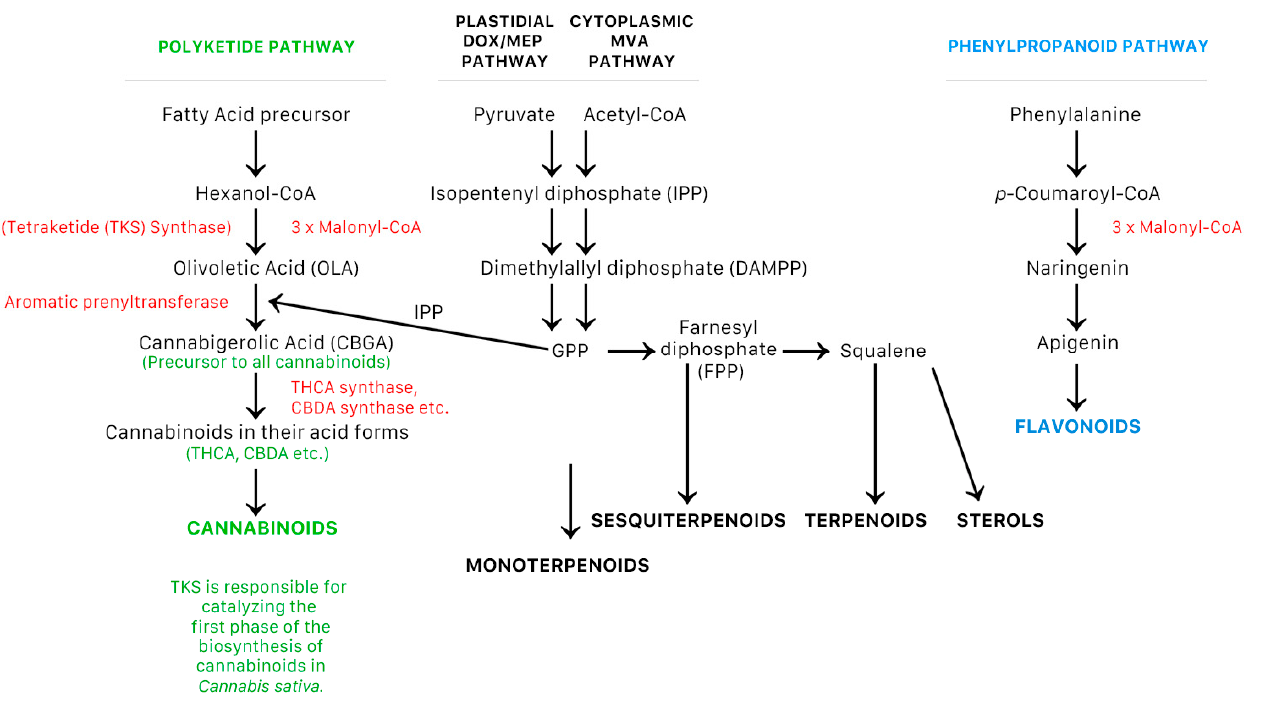
Figure 1. Synthesis of cannabinoids and non-cannabinoids produced by Cannabis sativa L. [2].